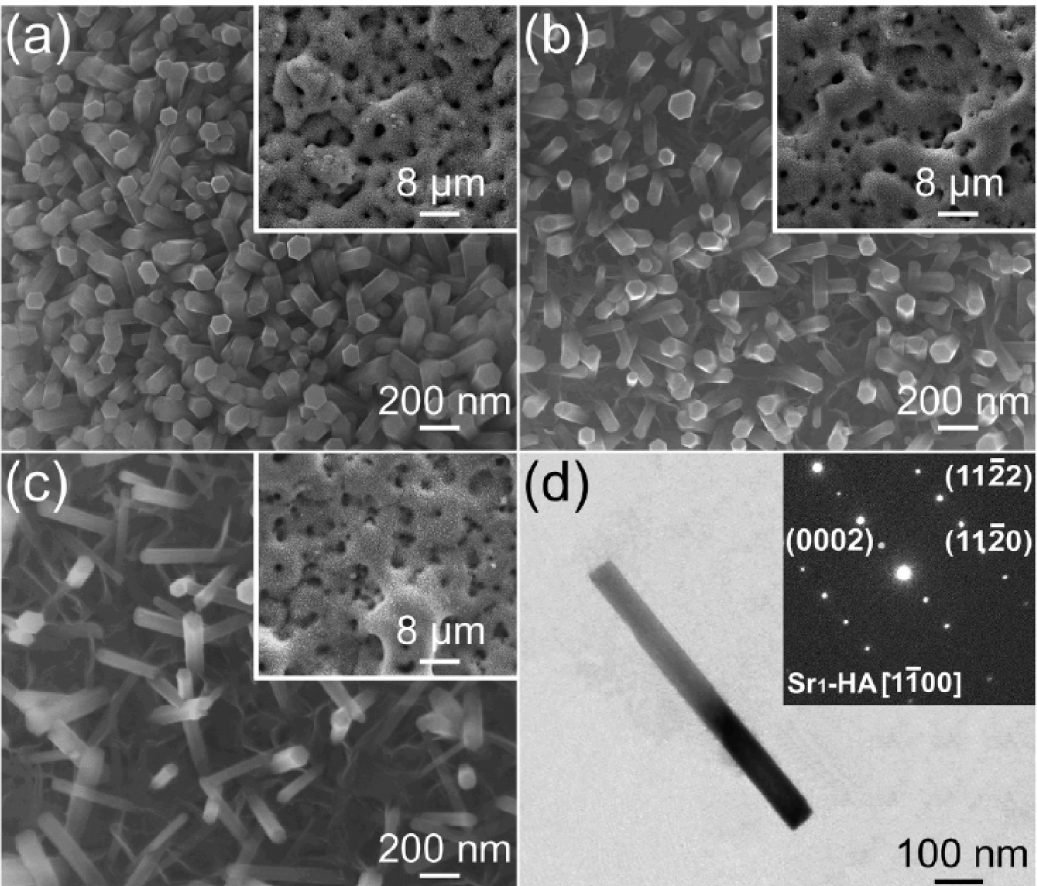
Figure 9. Scanning electron microscope (SEM) images of the surface morphologies of the microarc-oxidized (MAO) and hydrothermally treated coatings for: ( a ) S67, ( b ) S96, and ( c ) S137 (insets show the corresponding low-magnification images). ( d ) TEM bright-field image of the scratched nanorod from the S137 coating (inset showing the SAED pattern). Reproduced from [97], with permission of American Chemical Society 2013. Abbreviations: S67, nanorods with interrod spacing values of 67.3 ± 3.8; S96, interrod spacing values of 95.7 ± 4.2; and S137, interrod spacing values of 136.8 ± 8.7